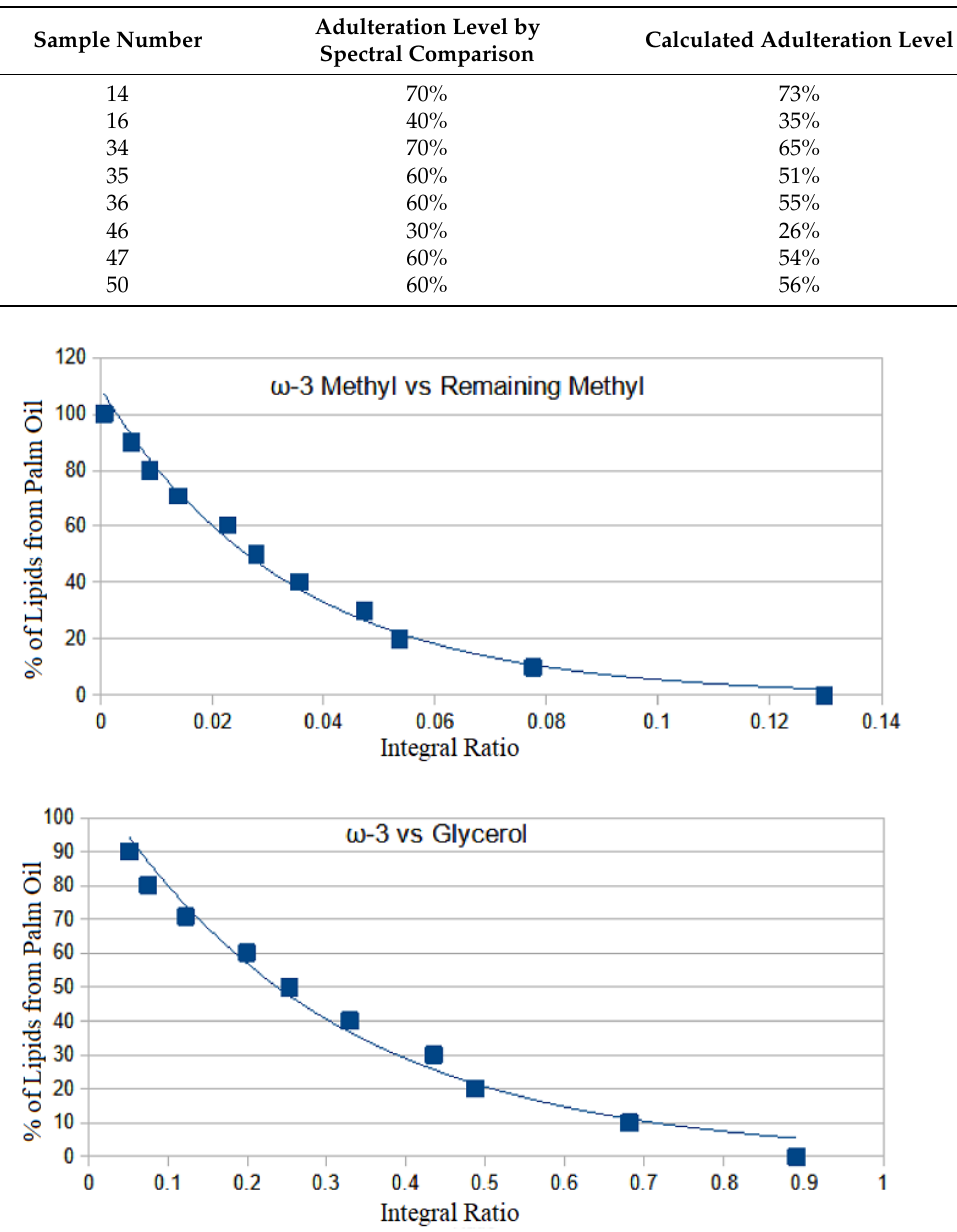
Figure 7. Calibration curves obtained from 1 H NMR spectra of serially adulterated cheese using palm oil. Table 3. Calculated levels of palm oil in adulterated samples.